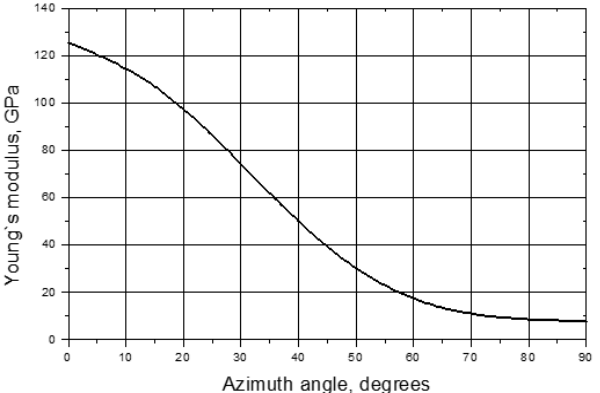
Figure 8. In-plane anisotropy of Young’s modulus in UD-CFRP calculated by “identical wave structure” approach.